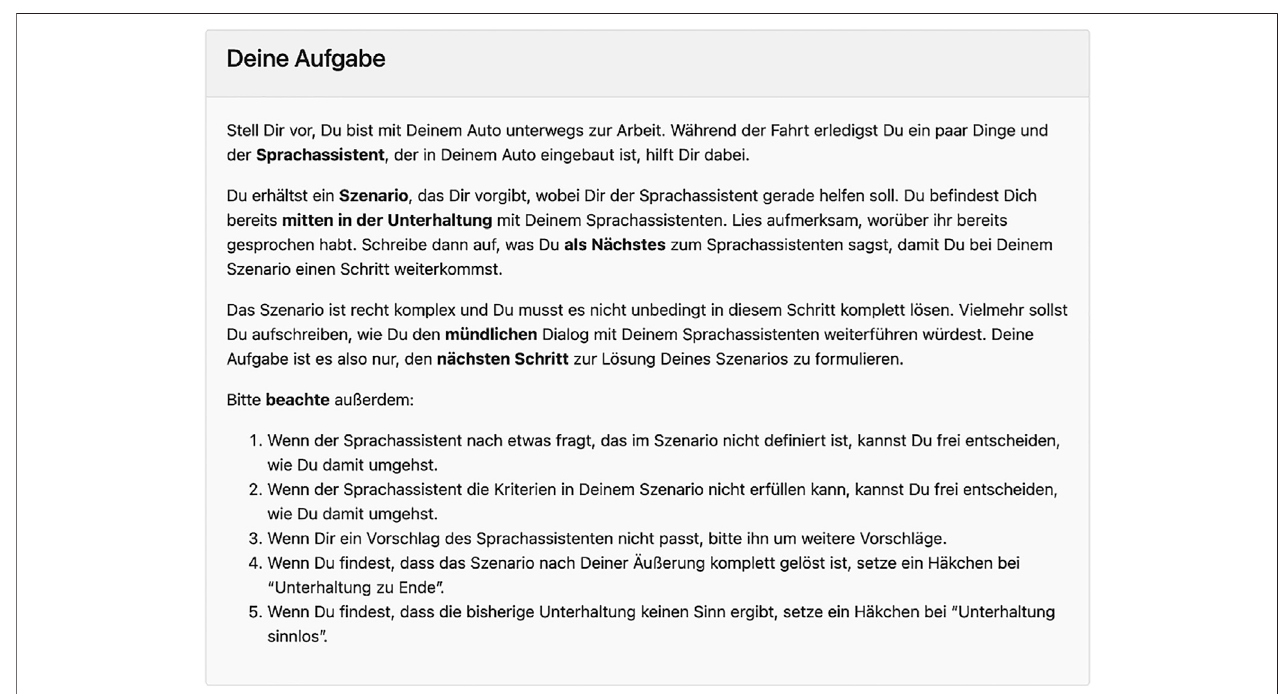
FIGURE 1 | Instructions familiarizing the user participants with their